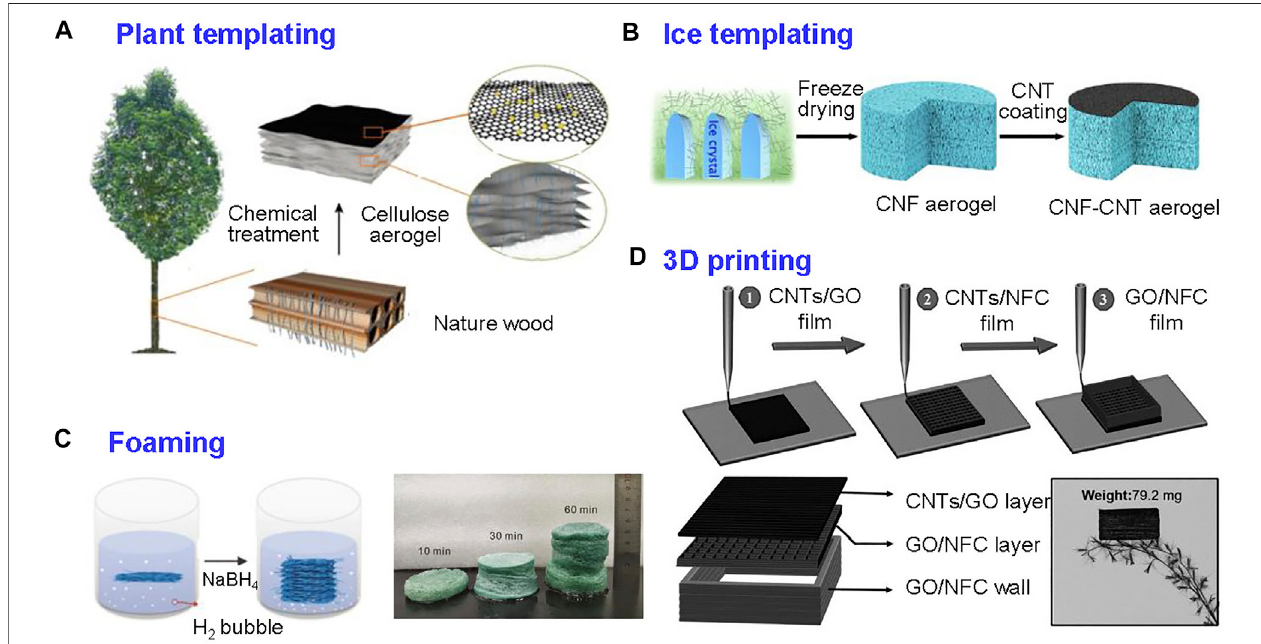
FIGURE 7 | Porous structures construction strategies for fi brous aerogels. (A) Plant templating: utilize the origin structure of nature plant to produce cellulose aerogels.Reprintedwithpermissionfrom(ZhangQ.etal.,2020).Copyright(2020)AmericanChemicalSociety. (B) Ice-templating:prepare fi brousaerogelswithoriented pore structure. Reprinted with permission from (Jiang et al., 2018). Copyright (2018) American Chemical Society. (C) Foaming: produce porous fi brous aerogels with expansiontreatmentof2Dnano fi brousmembrane.Reprintedwithpermissionfrom(LiH.etal.,2021).Copyright(2021)WILEYVCH. (D) 3Dprinting:design fi brous aerogels with programmed control of ink extrusion. Reprinted with permission from (Li et al., 2017c). Copyright (2017) WILEY VCH.